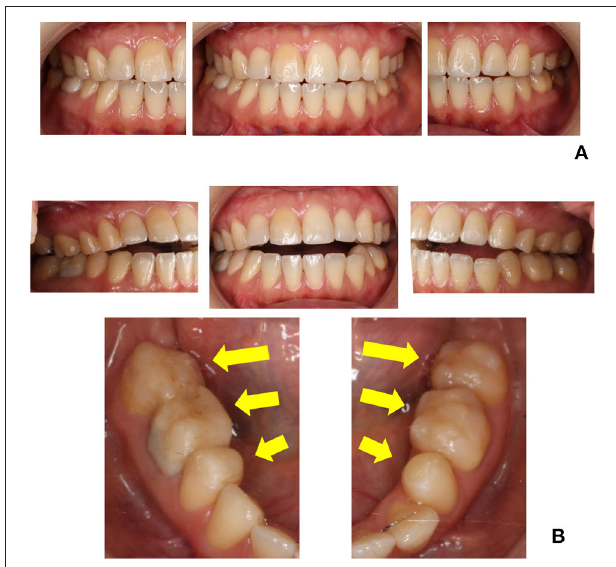
FIGURE 3 | Intraoral pictures at the first visit (A) and revisit (B) in case 3. The dental composite resin was constructed on her molars according to her demands; however, anterior open bite was